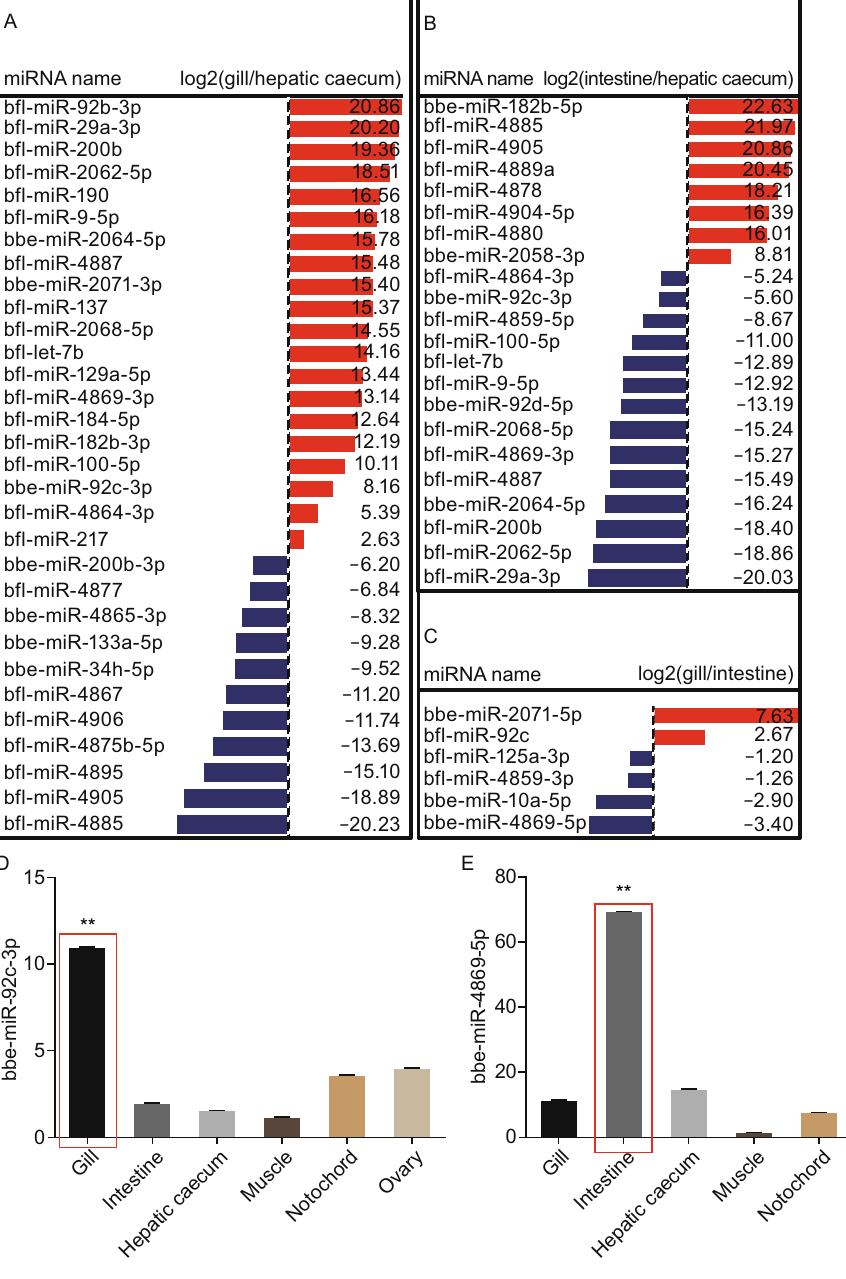
Figure 2. Statistical analysis the expression difference of miRNAs in paired organs of amphioxus, and validation of the expression of tissue-speci fi c miRNAs . The relative expression levels of miRNAs identi fi ed from the B. fl oridae and B. belcheri were statistically compared using the Student ’ s t test. The miRNAs with signi fi cant difference in the comparisons of gill versus hepatic caecum (A), intestine versus hepatic caecum (B) and gill versus intestine (C) were shown. The red color indicates high expression of miRNAs in the organs listed as the numerator and the blue indicates high expression of miRNAs in the organ listed as the denominator. The quantitative PCR results of the expression of the following miRNAs in the gill, intestine, muscle, hepatic caecum, notochord and ovary were shown: bbe-miR-92c-3p (D), bbe-miR-4869-5p (E), bbe-miR-4867-3p (F), bbe-miR-182b-5p (G), bbe-miR- 375-3p (H), bbe-miR-29a-3p (I), bbe-miR-200b-3p (J) and bbe-miR-2071-5p (K). The data are expressed as a ratio to the expression level of U6 and are plotted as the means ± SD. (* P < 0.05, ** P <